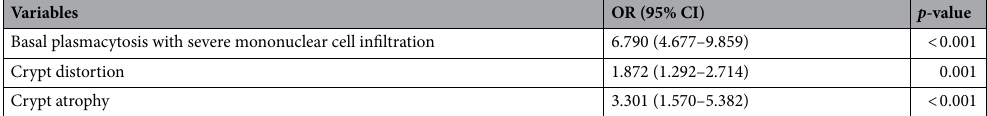
Table 3. Relationship between histological inflammation (hPDAI ≥ 3) and the IBD-specific findings. OR odds ratio; CI confidence interval; hPDAI pouchitis disease activity index histology subscore; IBD inflammatory bowel disease.